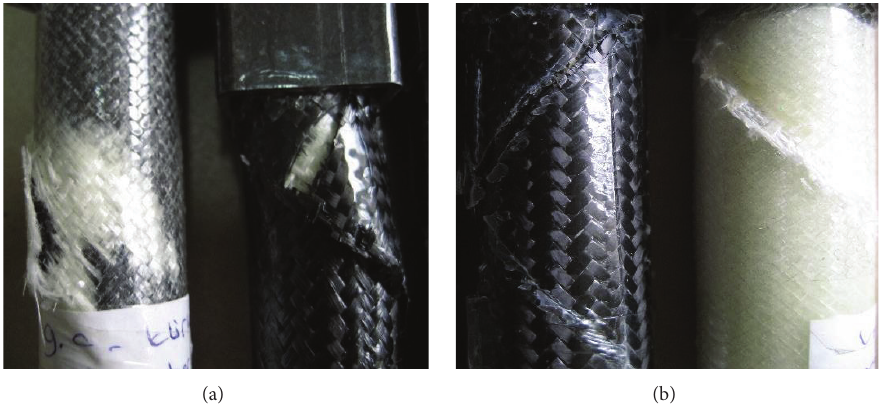
Figure 13: (a) Delaminated hybrid shafts. (b) Single-type fiber used shafts without